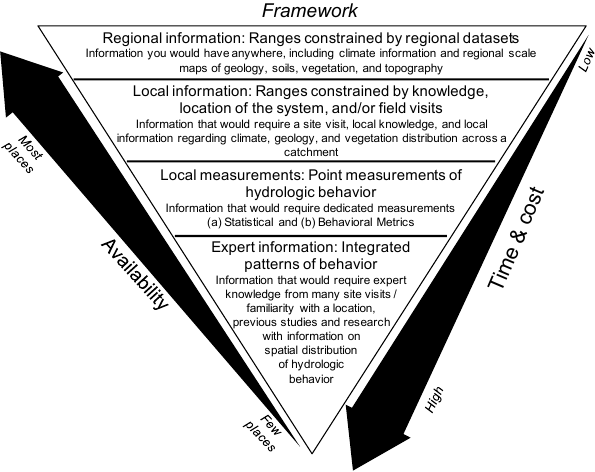
Figure 2. Conceptual framework for constraining environmental predictions for application to a distributed hydrologic model. The framework begins with criteria based on information that have po- tential to be widely available and relatively inexpensive to acquire, to criteria based on observations, ending with criteria based expert knowledge that may not be available or achievable